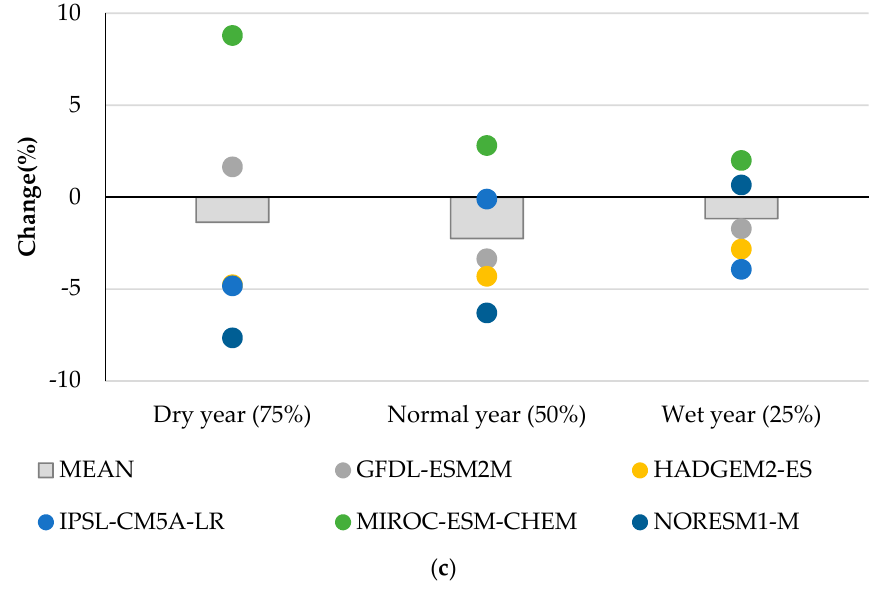
Figure 10. Power generation change under scenario ( a ) RCP2.6; ( b ) RCP4.5; and ( c ) RCP8.5.